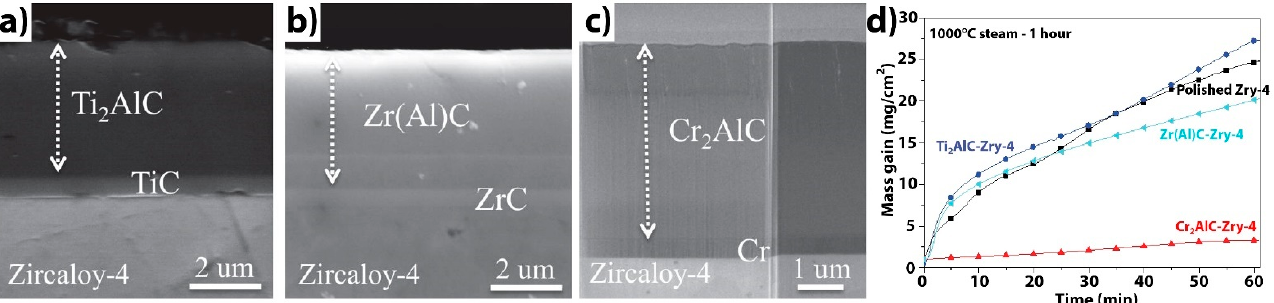
Figure 10. Cross-section images of three types of MAX-phase coatings with barrier layers on Zircaloy-4 after annealing: ( a ) Ti 2 AlC, ( b ) Zr(Al)C, ( c ) Cr 2 AlC, and their oxidation kinetics in 1000 °C steam ( d ). Reproduced from [159] with permission from the authors.